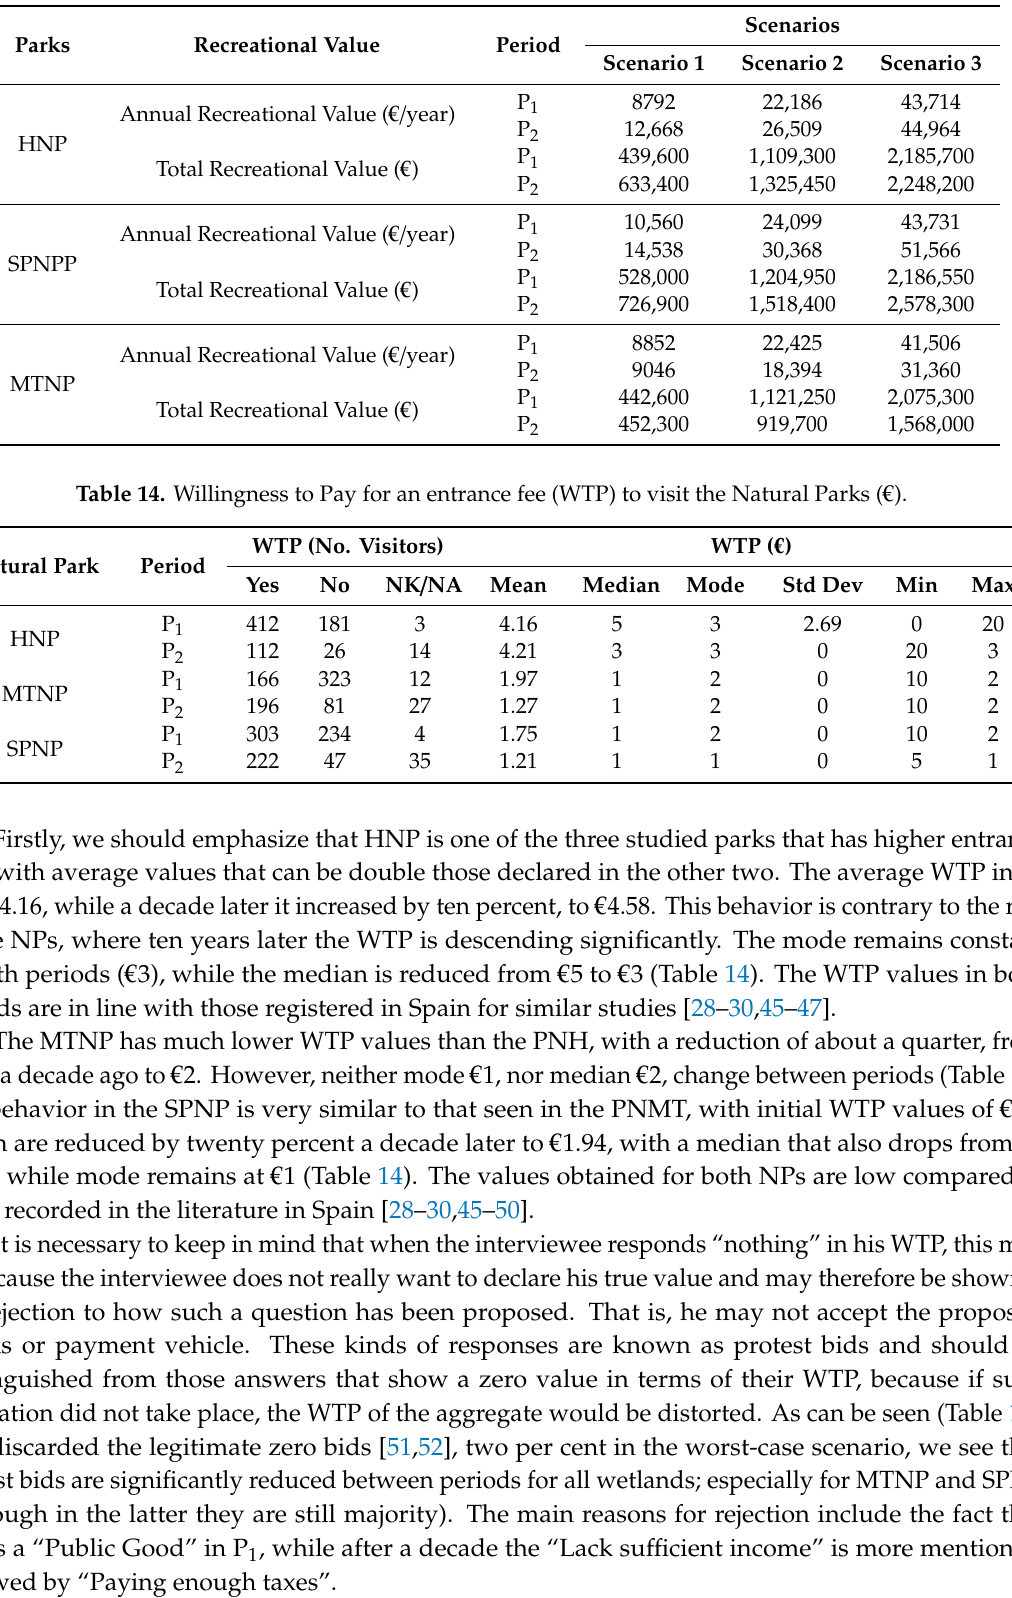
Table 13. Natural Parks´ Recreational Value ( € ) for Scenario and Period.